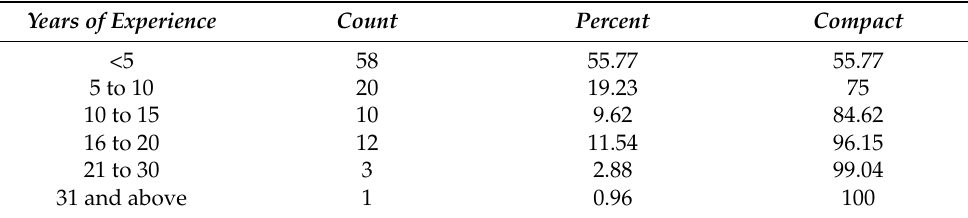
Table 3. Working experience of respondents in their relevant